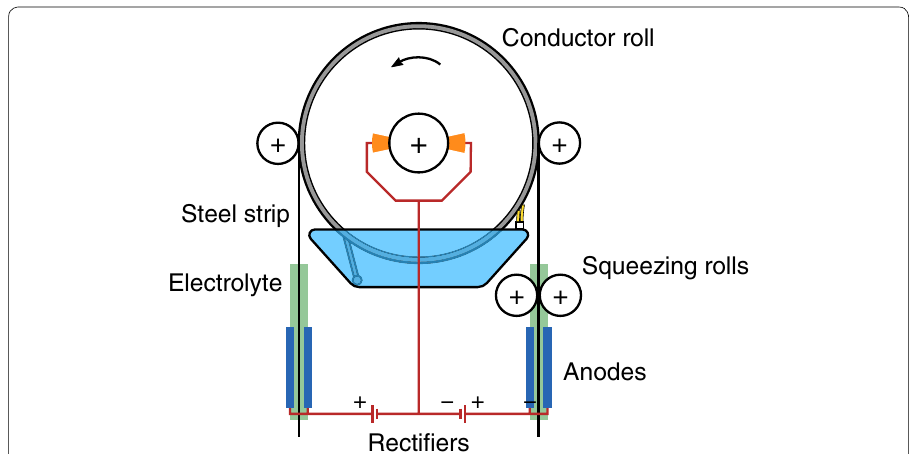
Fig. 2 Schematic drawing of a cell in the GRAVITEL electro galvanizing unit. One cell consists of four anodes, connected electrically in two couples. The respective cathode is the steel strip. The Zinc electrolyte flows between the anodes and the cathodic strip driven by gravity. Subsequently the electrolyte flows back into the circulation tank, which is located underneath the plating cells